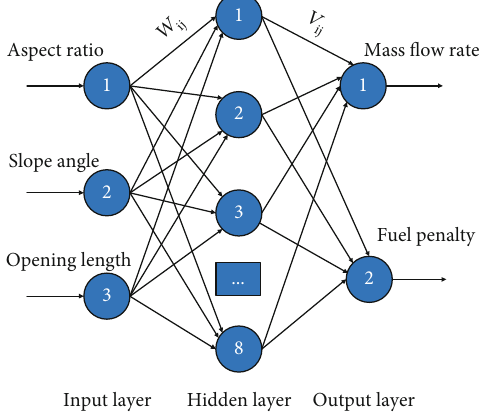
Figure 7: Topology of the BP neural network prediction model. Table 3: BP neural network parameters.